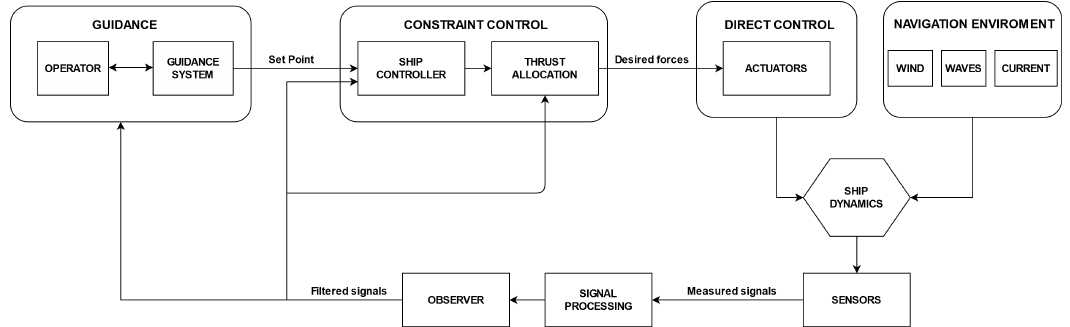
Figure 2. Components of a dynamic ship positioning